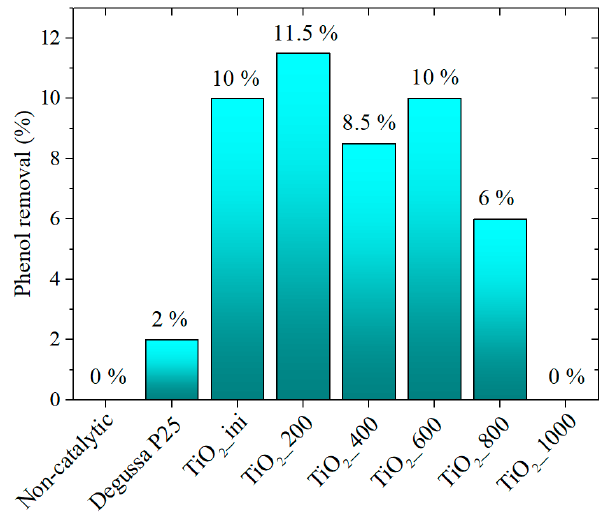
Figure 8. Photodegradation of phenol in water under visible light.